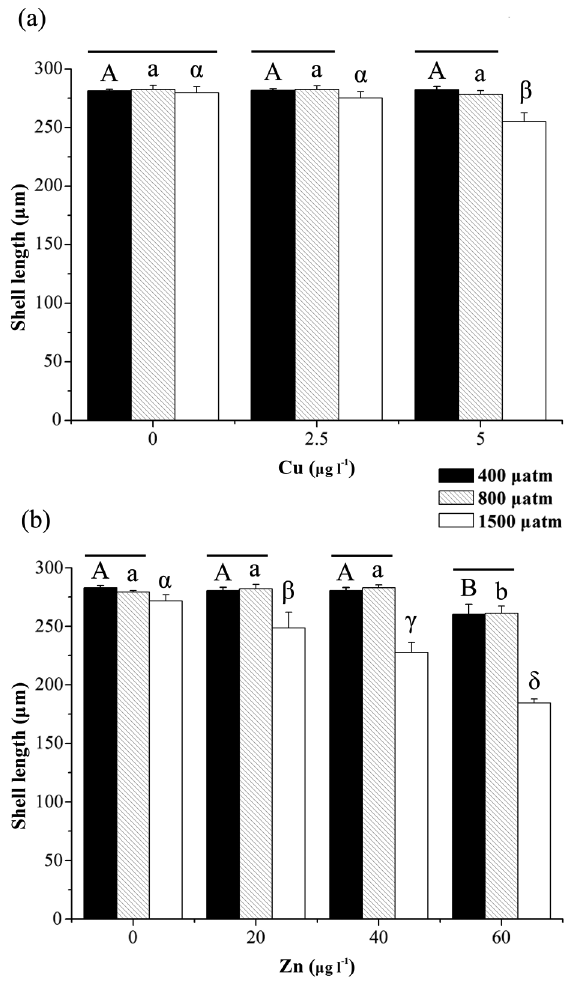
Fig. 7. Shell length (mean + SD; n = 4) of Crassostrea angu- Fig. 8. Shell length (mean + SD; n = 4) of Haliotis discus han- lata larvae 24 h post fertilization at 3 pCO 2 levels with the nai larvae 24 h post fertilization at 3 pCO 2 levels with the ad- addition of (a) Cu or (b) Zn. Different upper- and lowercase dition of (a) Cu or (b) Zn. Different upper- and lowercase let- letters represent significant differences between trace metal ters represent significant differences between trace metal concentrations at the same pCO 2 level (p < 0.05). A line concentrations at the same pCO 2 level (p < 0.05). A line above columns indicates no significant difference between above columns indicates no significant difference between pCO 2 levels at the same trace metal concentration. Columns pCO 2 levels at the same trace metal concentration. Columns not connected by lines are significantly different from each not connected by lines are significantly different from each other (p < 0.05) other (p <